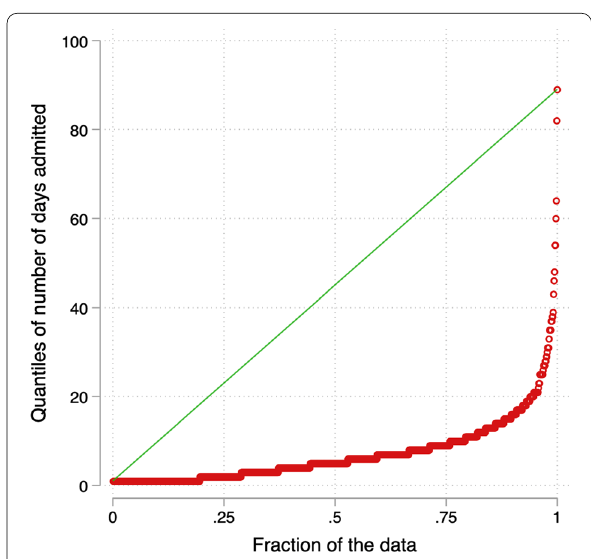
Fig. 2 Quantile plot showing days of hospitalization of COVID-19 patients in six hospitals in